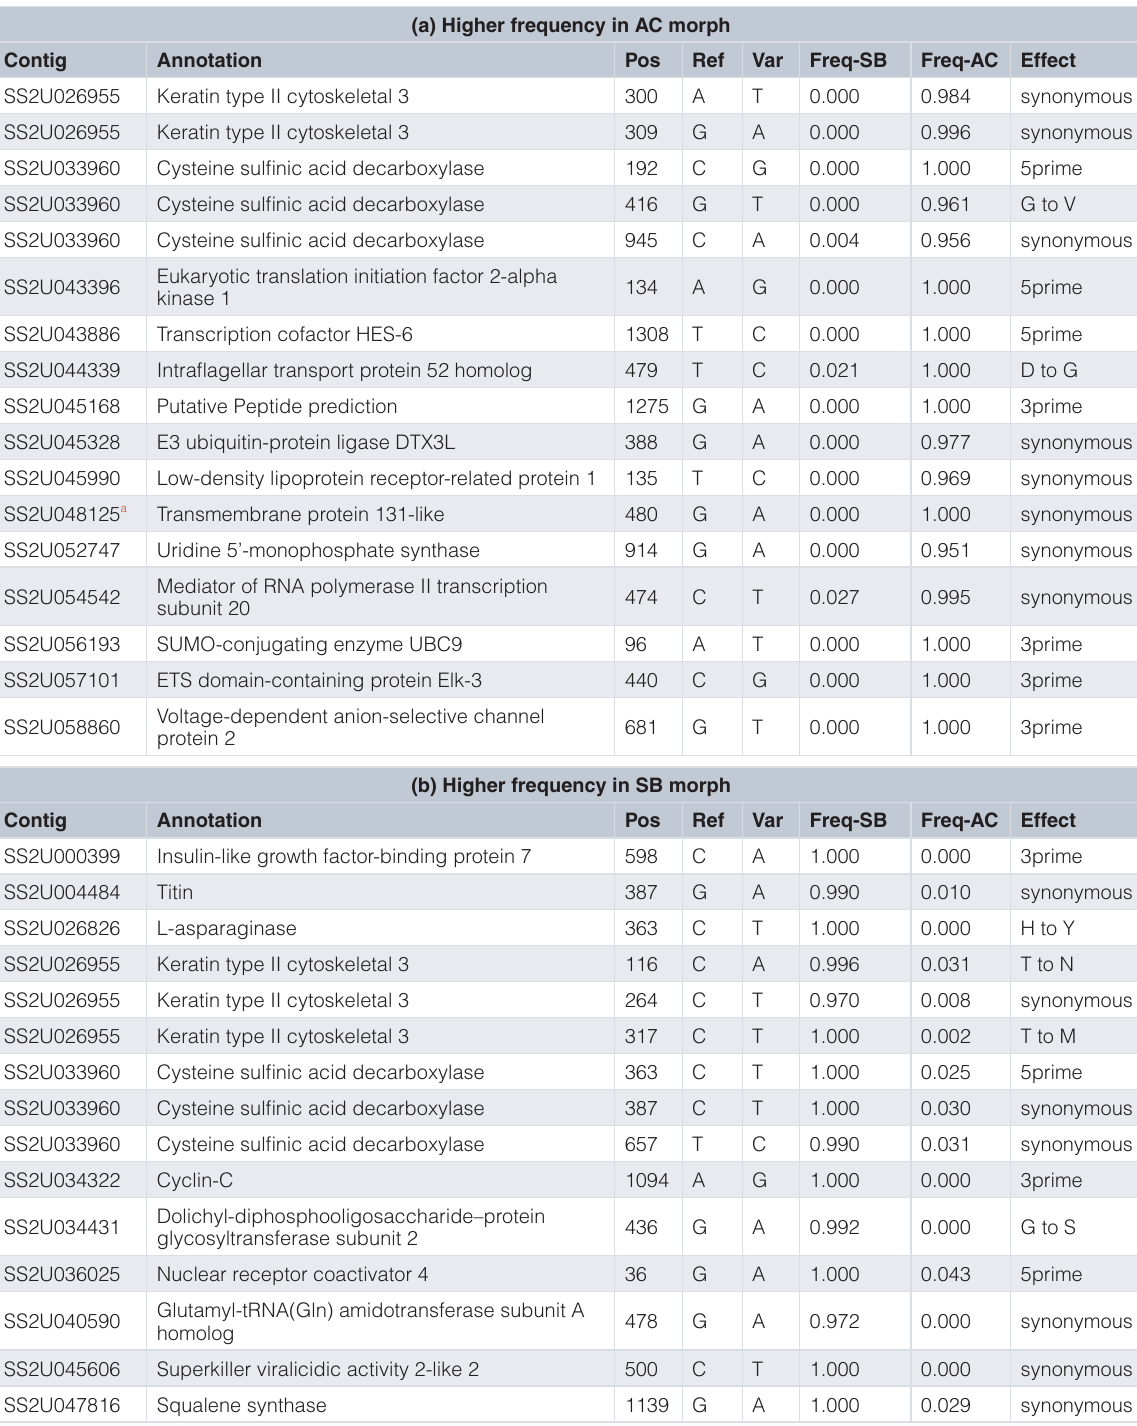
Table 5. SNP candidates from uniquely mapped